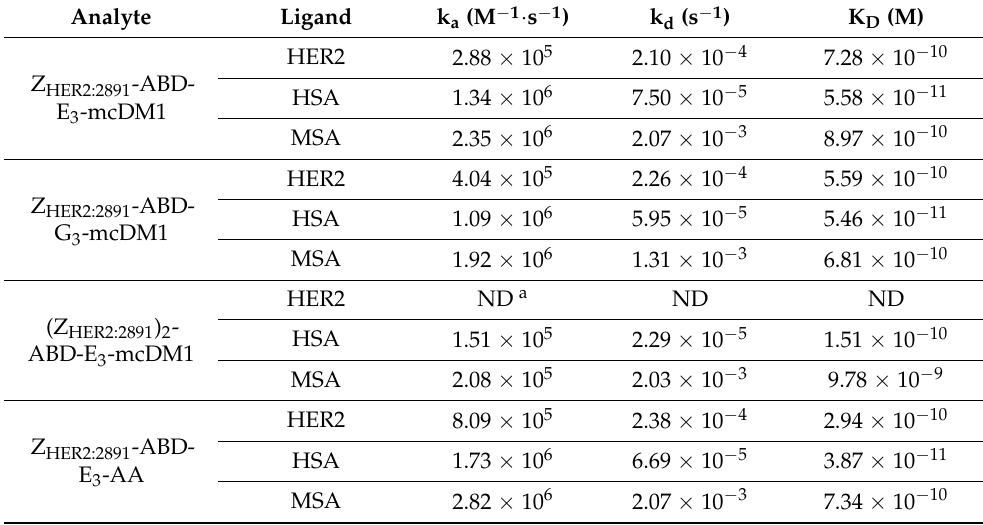
Table 2. Kinetic parameters and equilibrium dissociation